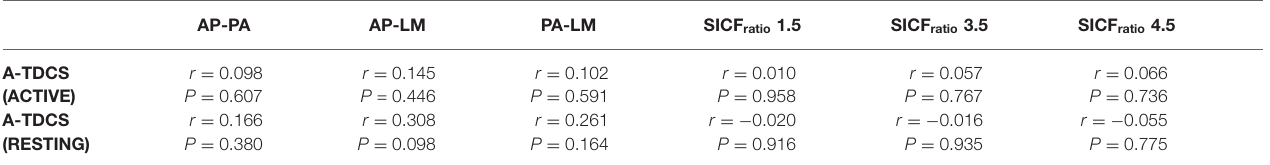
TABLE 3 | Correlations between latency differences, SICF ratio , and response to a-tDCS.